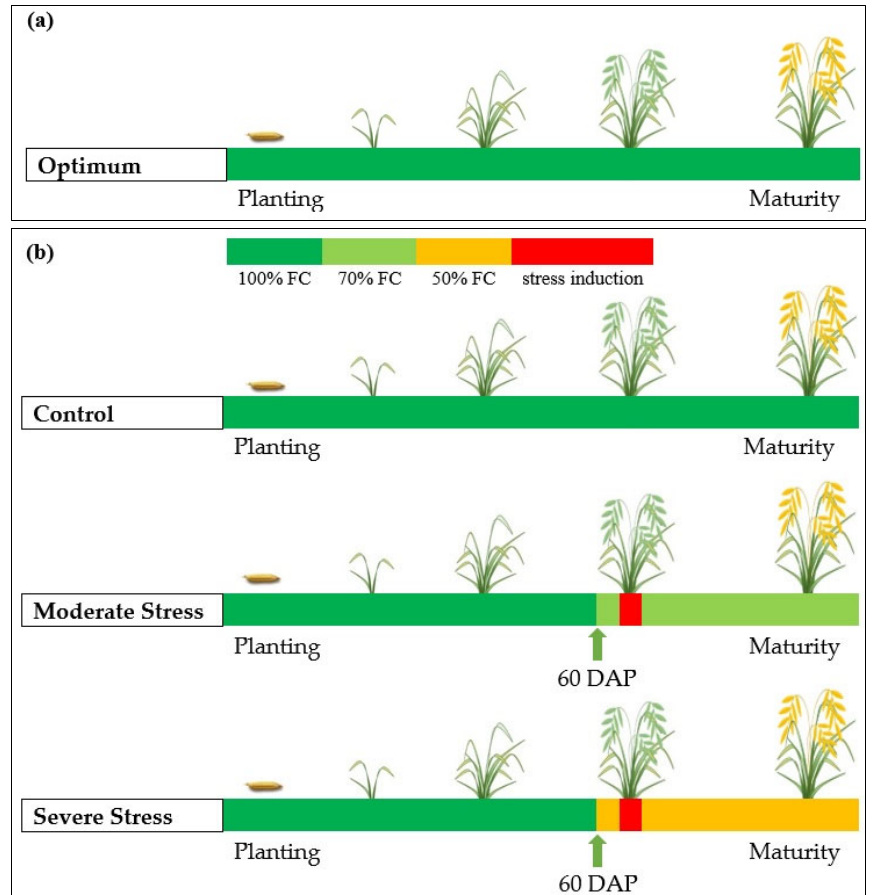
Figure 1. Schematic diagram of experimental setup indicating the potential experiment (1) under optimal conditions ( a ) and the yield assessment experiment (2) with three irrigation treatments ( b ). The dark green color indicates optimum and non ‐ water stressed conditions. The light green and orange color indicate the irrigation at 70% of field capacity (FC) and 50% of FC after 60 days of planting (DAP) for moderate stress and severe stress treatments, respectively, whereas, the red color indicates the stress induction duration for moderate stress and severe stress treatments in the yield assessment experiment.